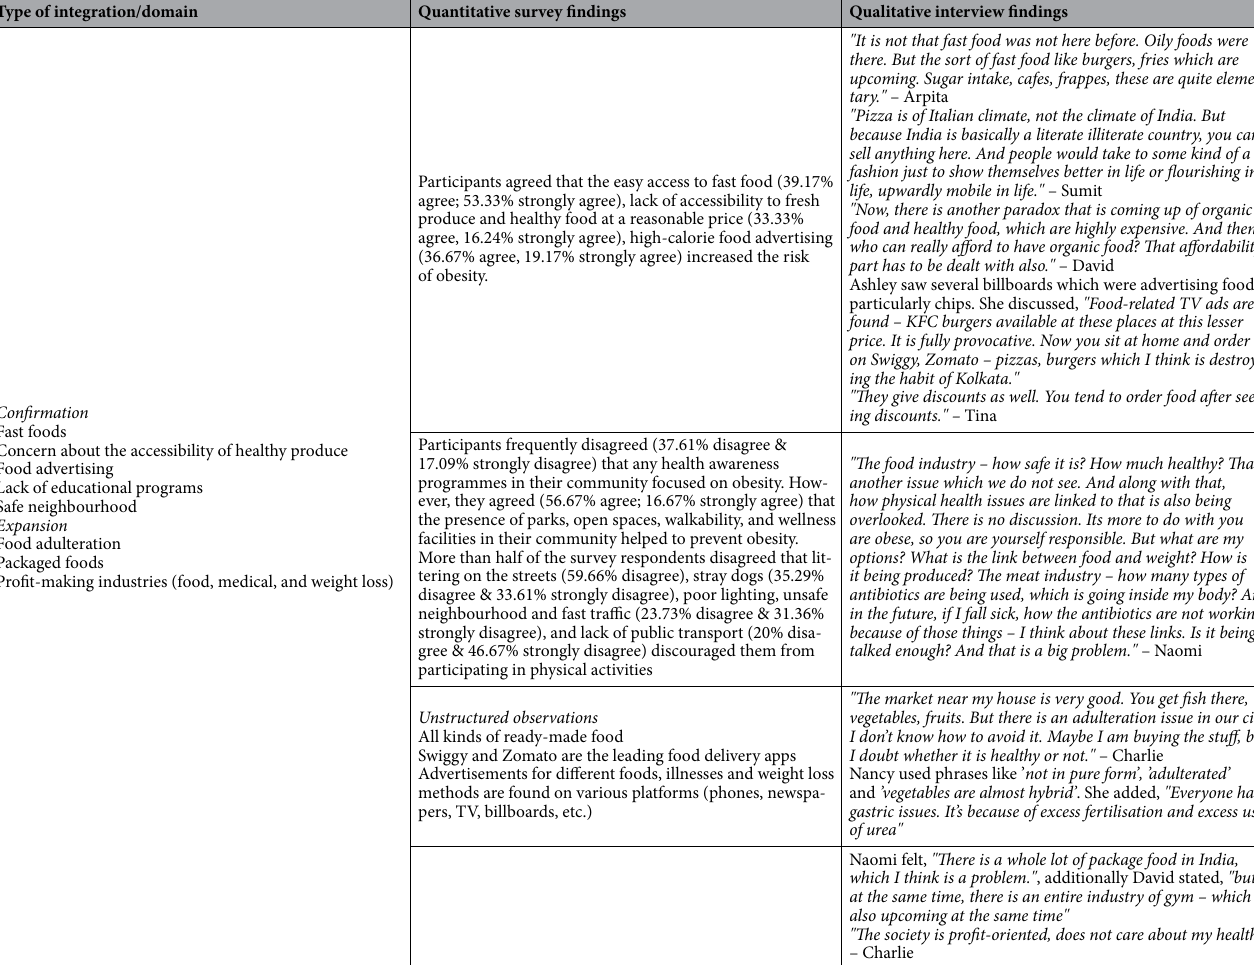
Table 3. Juxtaposed findings of quantitative and qualitative investigation on environmental determinants. Source: Primary